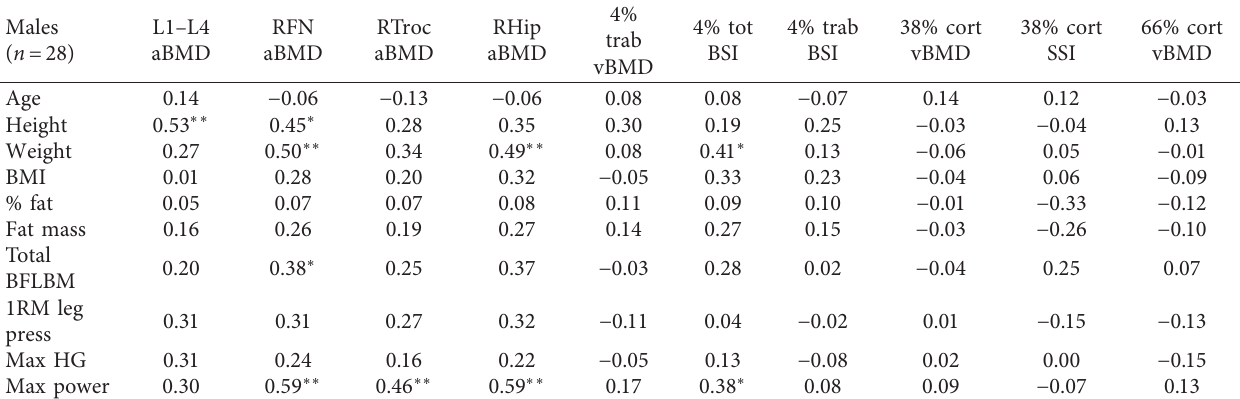
Table 6: Pearson correlation coefficients for age, height, body composition, muscle performance, and bone characteristics in males. Males ( n �